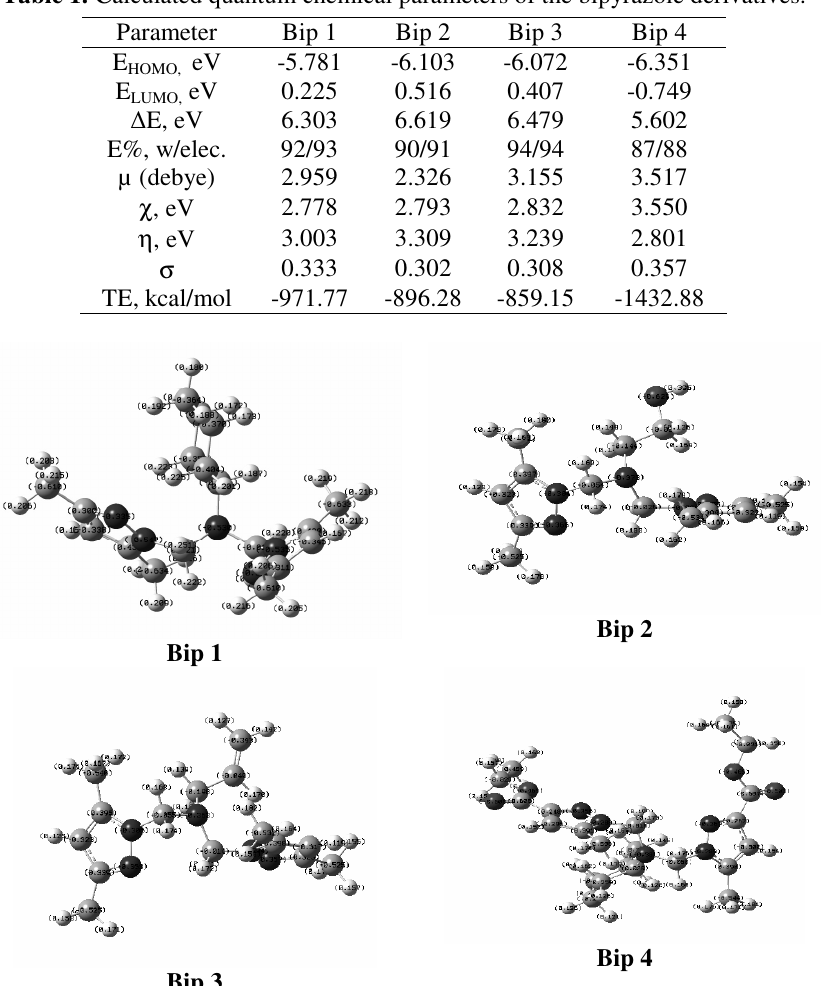
Figure 2. The optimized molecular structure of the inhibitor molecules Highest occupied molecular orbital energy ( E ) and lowest unoccupied molecular HOMO orbital energy ( E ), also called the frontier orbitals, determine the possibility of the LUMO molecule to interact with other reactants. E is often a measure of electron donating HOMO is likely to indicate a tendency of the molecule ability of the molecule. High value of E HOMO to donate electrons to appropriate acceptor molecule of low empty molecular orbital energy. The energy of the lowest unoccupied molecular orbital, E , denotes the ability of the LUMO , are more probable to molecule to receive electrons. In other words, lower values of E LUMO accept electrons. So, the gap energy, i.e . the difference in energy between the HOMO and LUMO, is an important stability